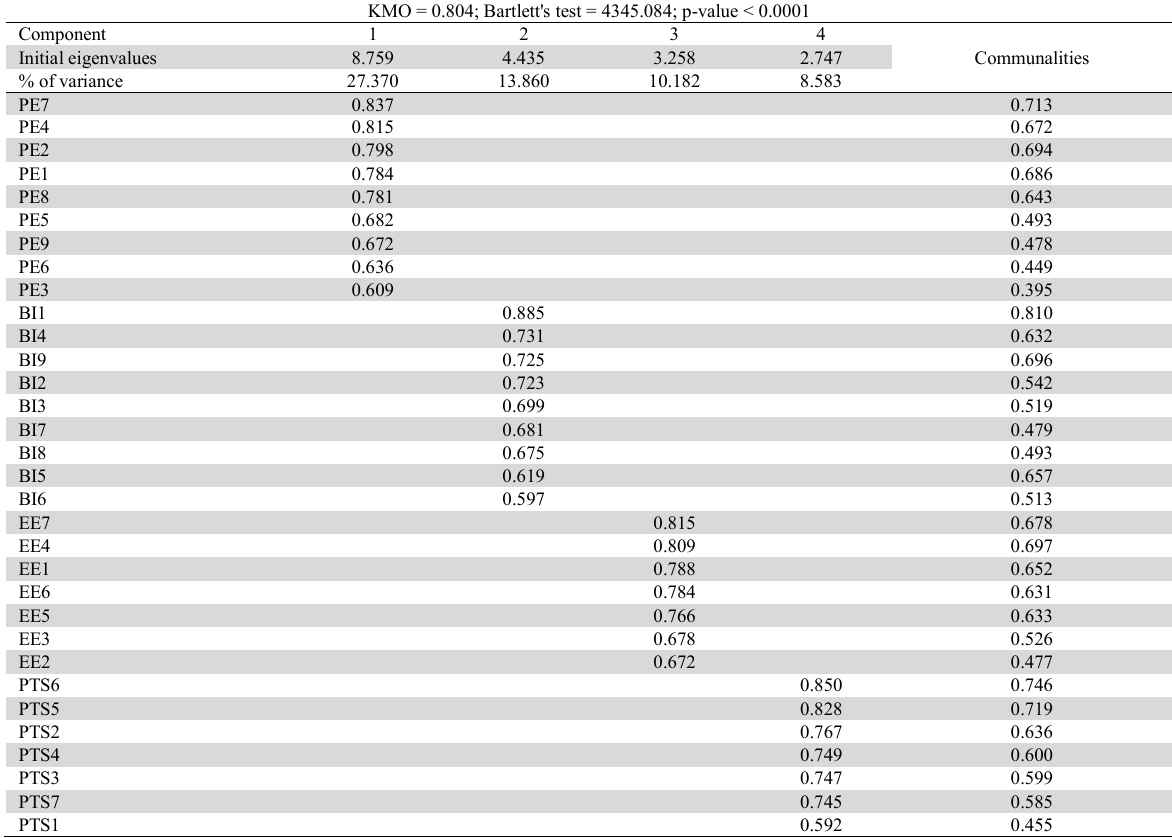
EFA analysis result after Varimax